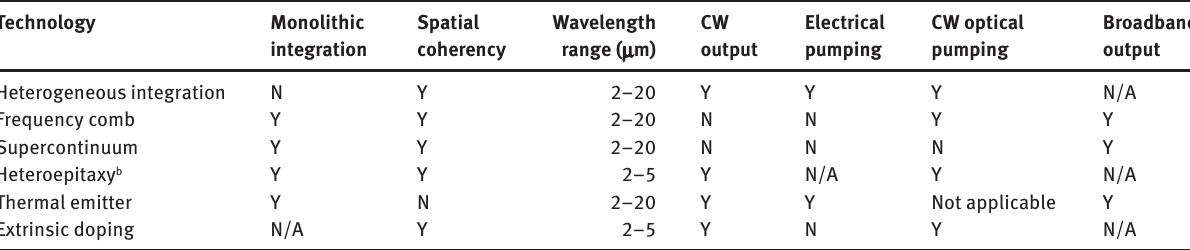
Table 4: Comparison of mid-IR on-chip light emitter technologies. a